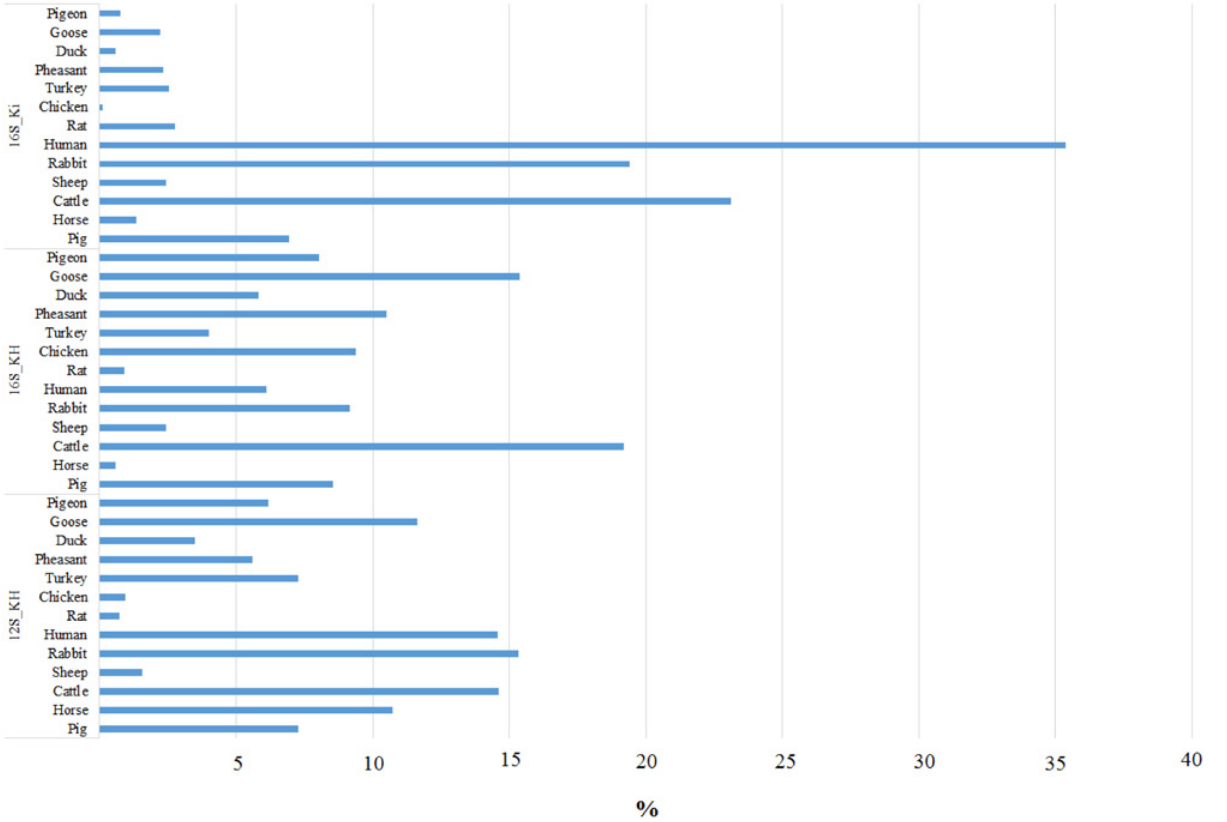
Fig 2. Percentage of reads obtained for the different primer pairs from library